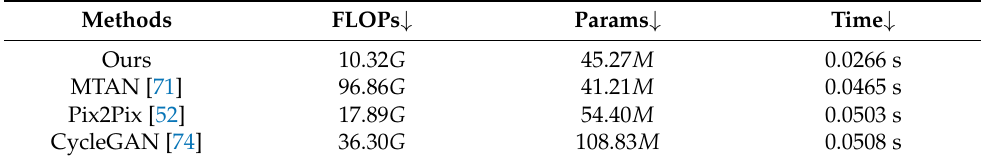
Table 2. The parameter quantity, calculation quantity and reasoning time of different methods.